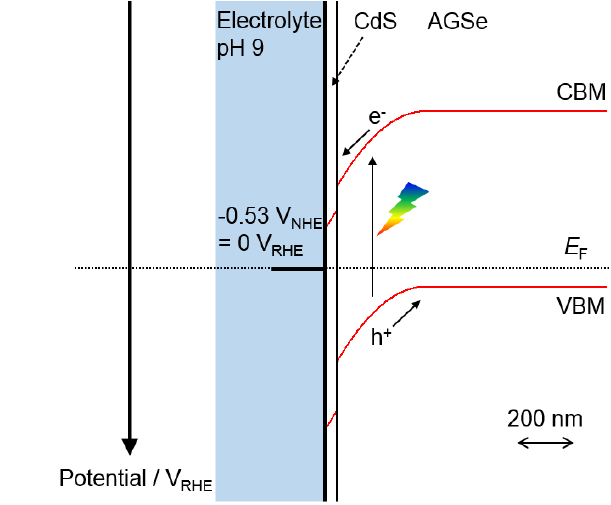
Figure 11. Schematic band alignment at a solid-electrolyte interface for the CdS/AGSe